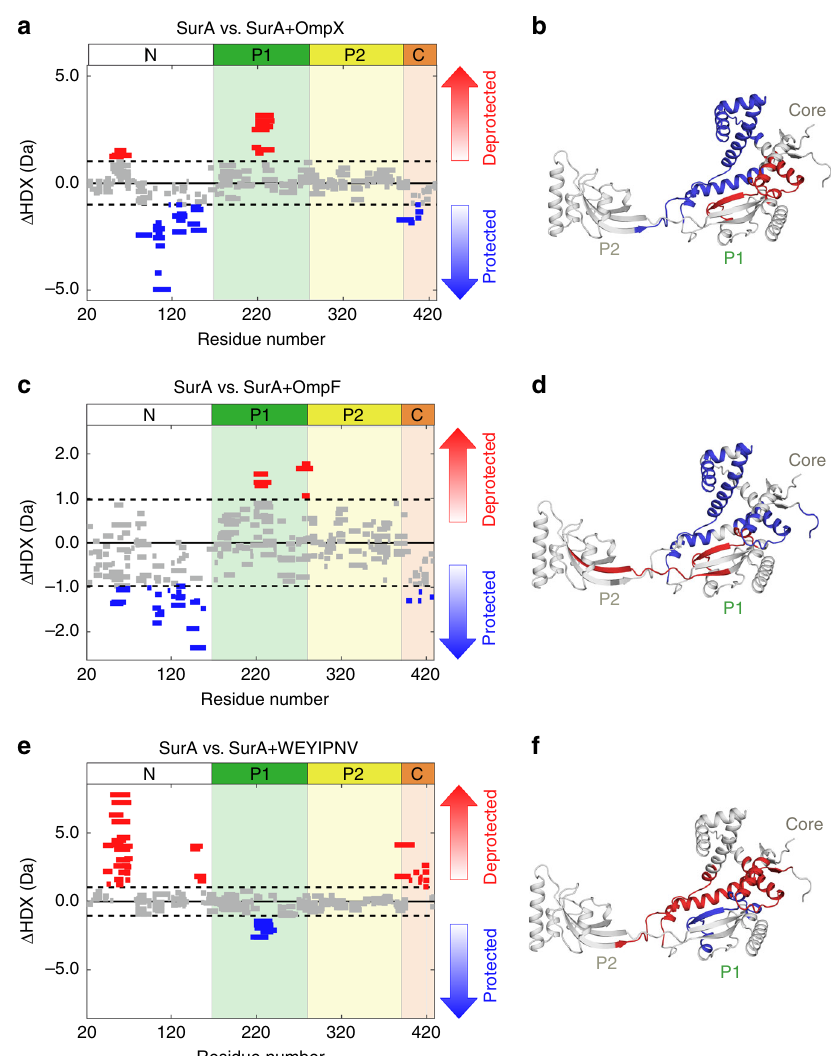
Fig. 6 SurA binding to different substrates leads to varying patterns of protection and deprotection by differential HDX-MS analysis. Wood ’ s plots showing the summed differences in deuterium uptake in SurA over all four HDX timepoints, comparing SurA alone with SurA in the presence of a OmpX, c OmpF or e WEYIPNV. Wood ’ s plots were generated using Deuteros 115 . Peptides coloured in blue or red, respectively, are protected or deprotected from exchange in the presence of OmpX/OmpF/WEYIPNV. Peptides with no signi fi cant difference between conditions, determined using a 99% con fi dence interval (dotted line), are shown in grey. Regions of SurA protected or deprotected in the presence of b OmpX, d OmpF and f WEYIPNV coloured in blue or red, respectively. Example deuterium uptake curves are shown in Supplementary Fig. 9. See Methods for experimental